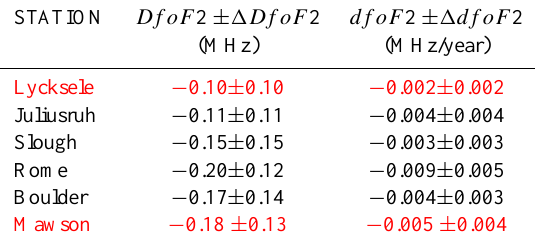
Table 3. Total f oF 2 trend rates ( Df oF 2) obtained along more than two solar cycles of observations made by mid and high lati- tude ionospheric stations (in red) and their respective yearly trend rates ( df oF 2). Both the quantities are referred to quiet magnetic